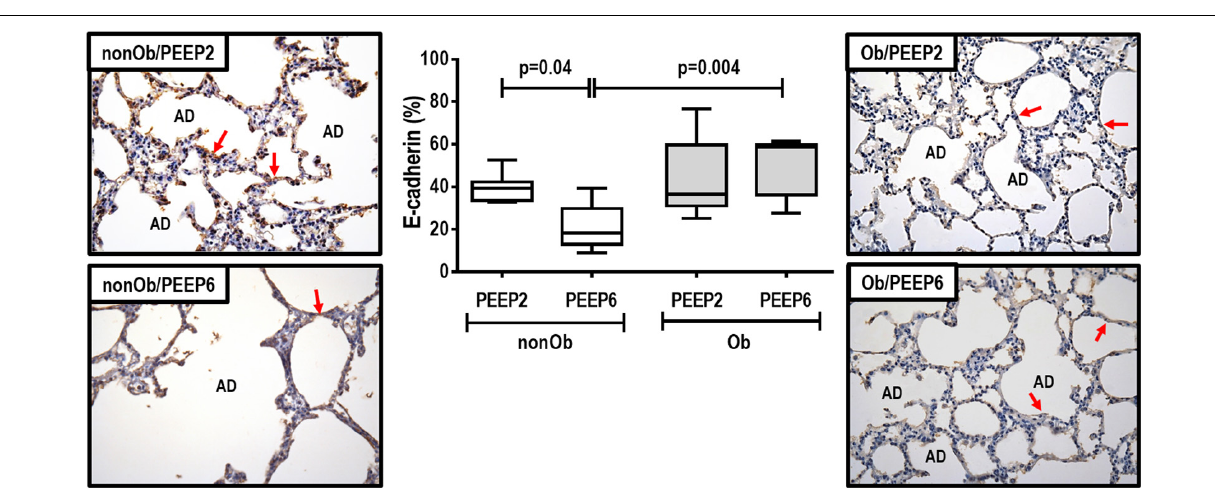
FIGURE 2 | E-cadherin tissue expression and representative photomicrographs of immunohistochemical staining for E-cadherin in mechanically ventilated obese groups: Low-PEEP (2 cmH 2 O) and High-PEEP (6 cmH 2 O). Boxes show the interquartile range (25th–75th percentile), while whiskers encompass the range (minimum-maximum) and horizontal lines represent the median in seven animals/group. Red arrows represent E-cadherin immunohistochemical staining (brown). AD, alveolar ducts. Original magnification ×